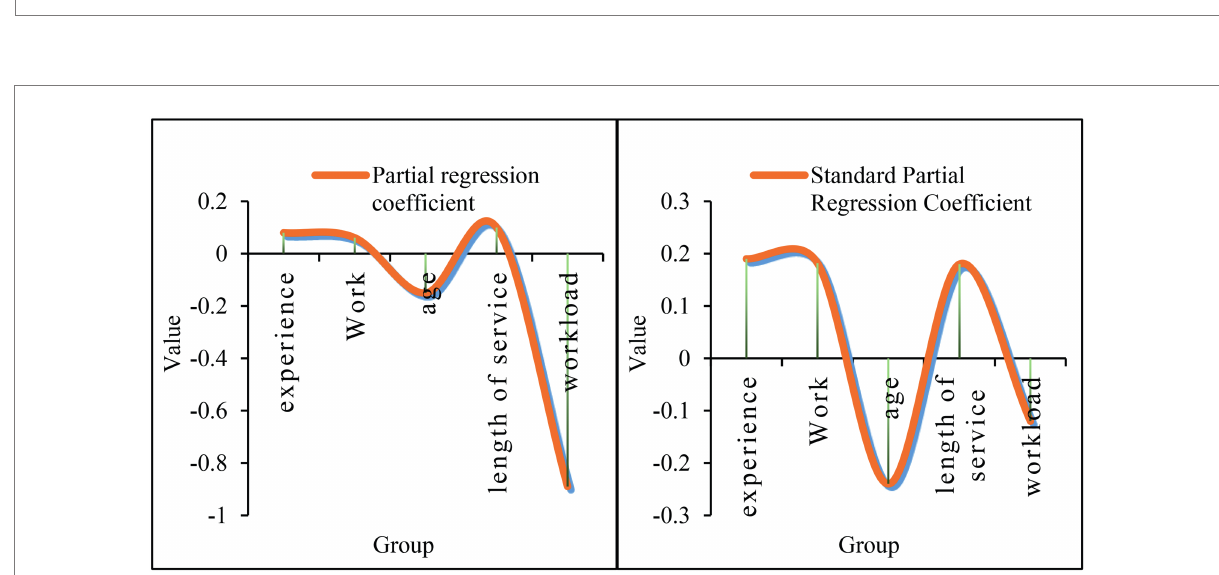
FIGURE 9 Multi-factor stepwise analysis of the effect of occupational stress on hostile factors.